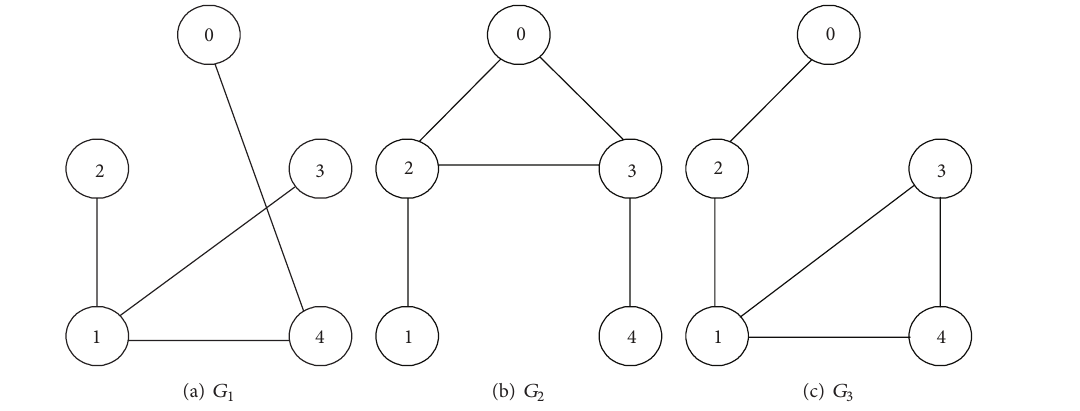
Figure 3: Trajectories V